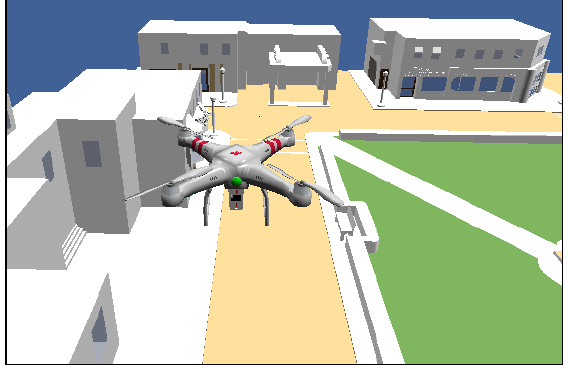
Figure 1. UAV-based mapping simulated